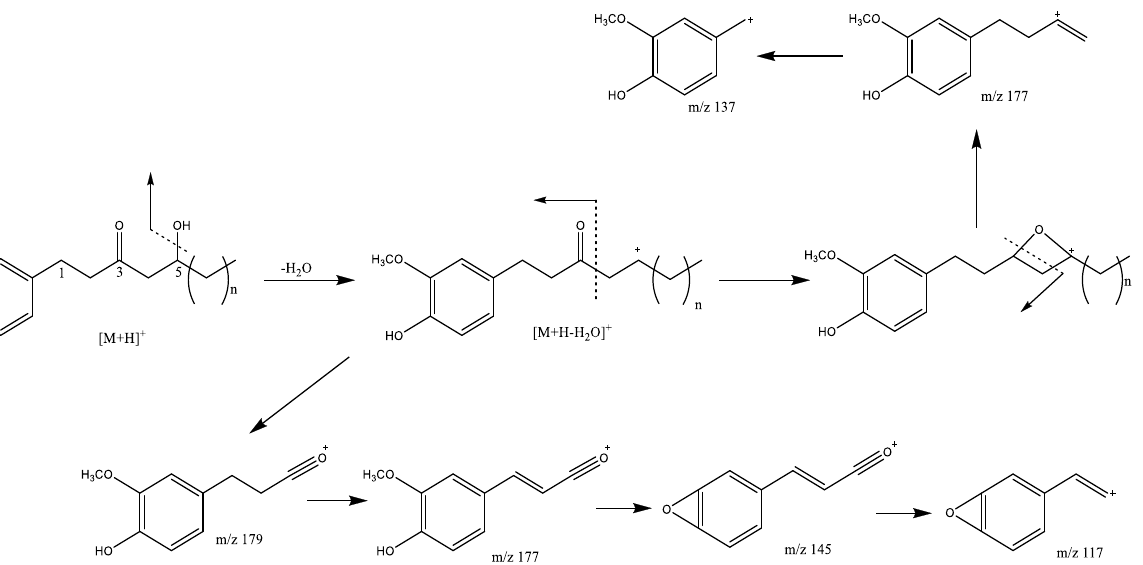
Figure 3. Fragmentation pathway for gingerol compounds 1 ( n = 4), 3 ( n = 6), 10 ( n = 8), 23 ( n = 10), 30 ( n = 12). Peaks 7 (Rt = 15.82 min) and 25 (Rt = 24.76 min) correspond to methyl-6-gingerol and methyl-8-gingerol, respectively, based on the adduct [M+Na] + at m/z 331.1985 (C 18 H 28 O 4 Na)